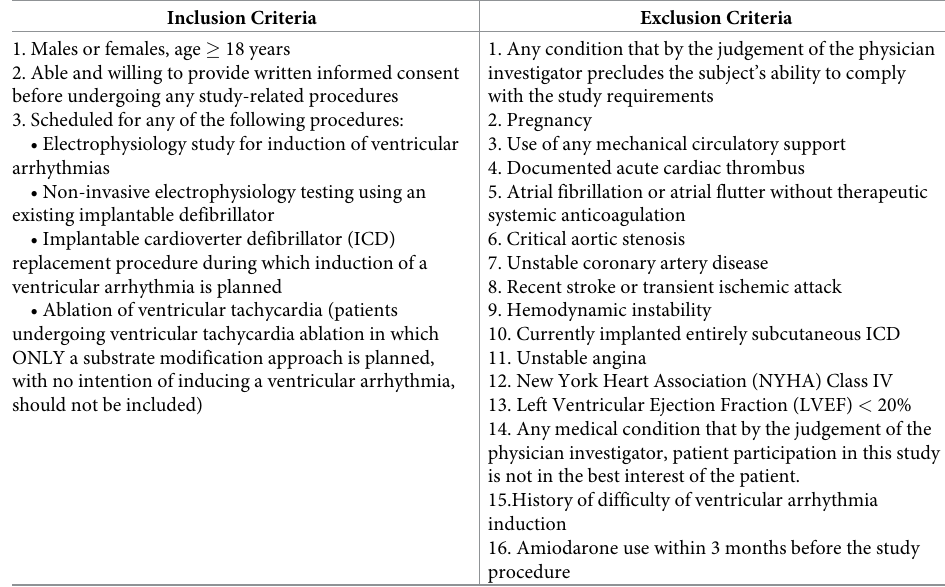
Table 2. Human study eligibility